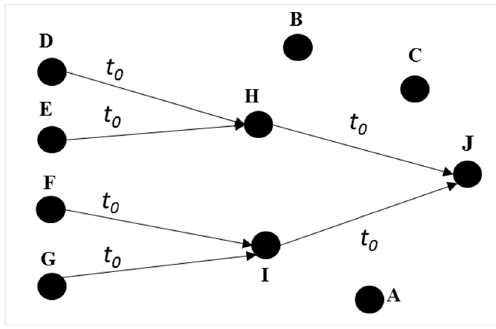
Figure 11. Initial state of unknown attack.